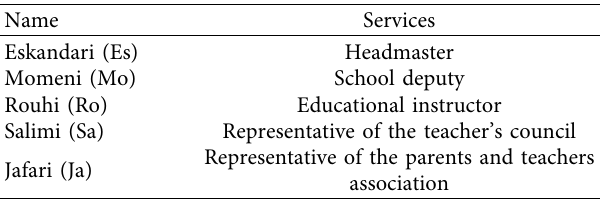
Table 2: The names of the staff and their specialization in the school. Name Services